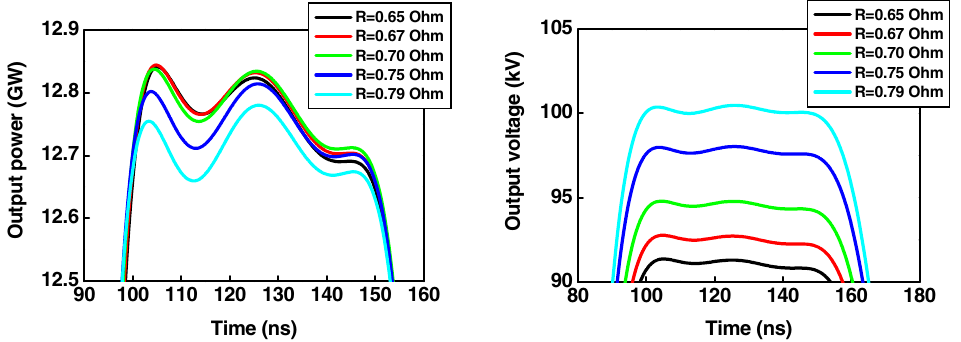
FIG. 6. Output power and voltage of the output pulse of the LTD cavity in 11 S þ 7 M þ 2 F configuration depending on the resistance of the cavity load R